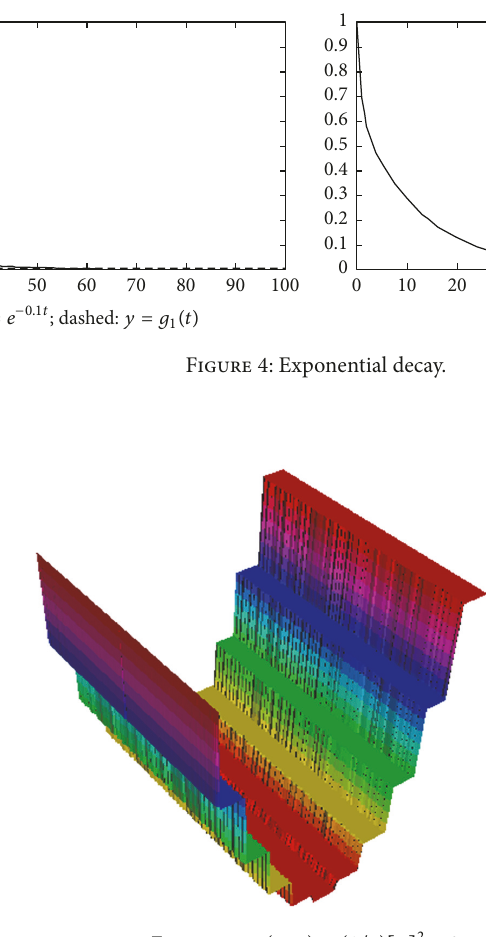
Figure 5: 𝑝 ℎ (𝑥, 𝑦) = (1/5)⌈𝑥⌉ 2 + 2.5